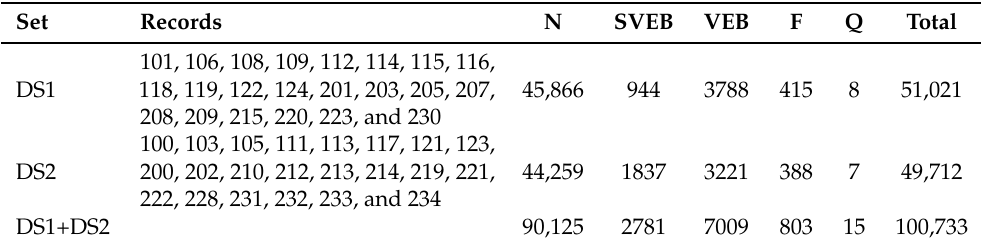
Table 2. Heartbeat distribution by classes and records of sets/parts as proposed by